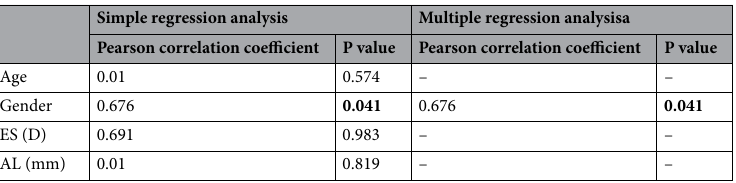
Table 2. The correlation between the number of vortex vein ampulla per eye and age, gender, logMAR visual acuity, equivalent spherical, and axial length. ES equivalent spherical, AL axial length. These factors are selected by the backward forward stepwise method. Statistically significant results were written in bold letter.